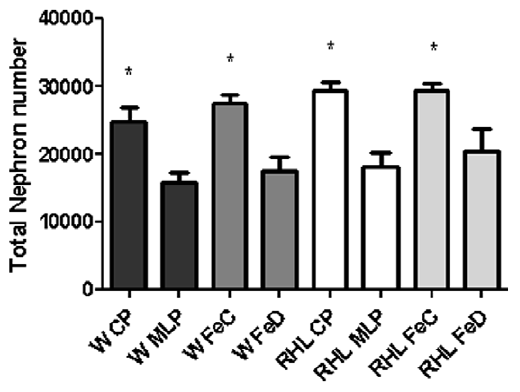
Figure 1. Nephron numbers in each diet/strain group. Data are mean 6 SE. *P , 0.05 between control and corresponding deficient diet. n=8 animals per group. doi:10.1371/journal.pone.0023189.g001 PLoS ONE |